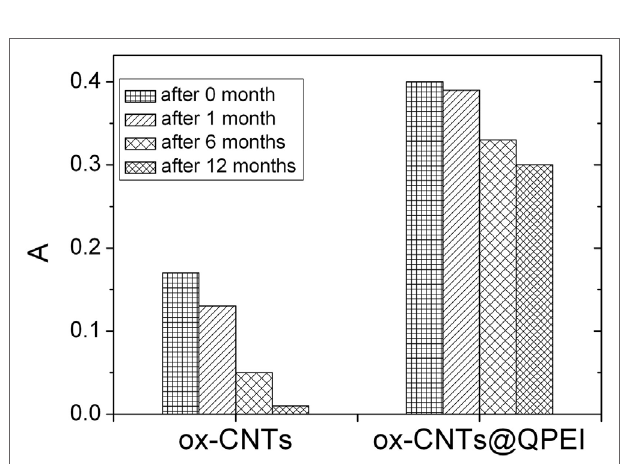
FigUre 5 | Sedimentation behavior of oxidised­carbon nanotubes (ox­CNTs) and ox­CNTs@QPEI at different aging time.